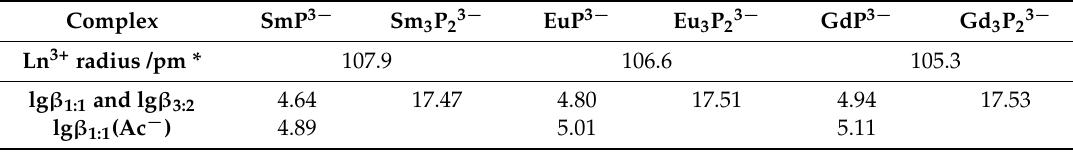
Table 1. Formation constants for the mono- and bisporphyrin complexes of Sm(III), Eu(III), and Gd(III). Complex